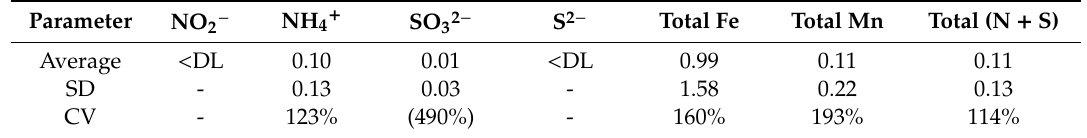
Table 4. Main characteristics of minor ions analyzed during baselining.